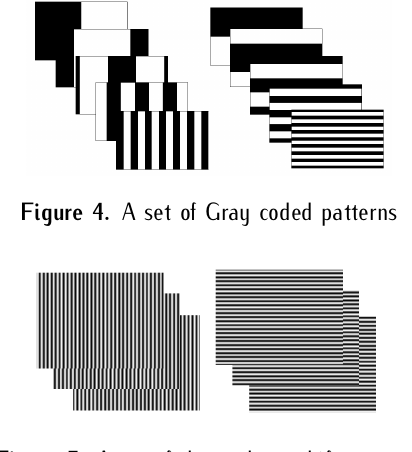
give sub pixel precision. For this reasons, Gray coded and three phase shift methods are combined [16].